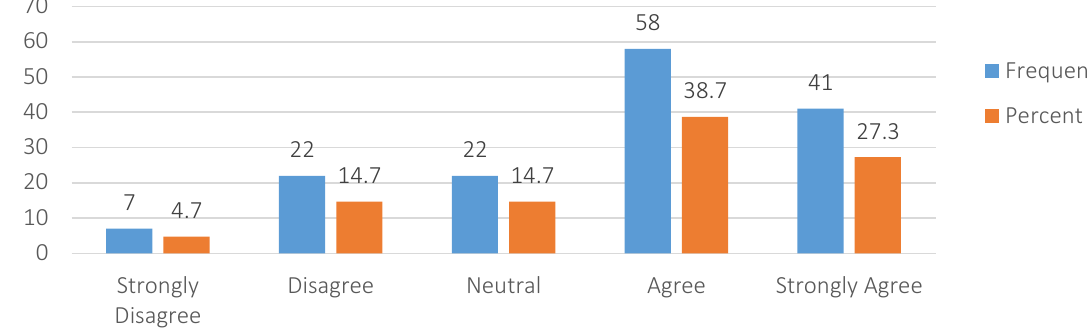
Figure 1. The adoption of MAPs is influenced by the enterprise age and years of being in